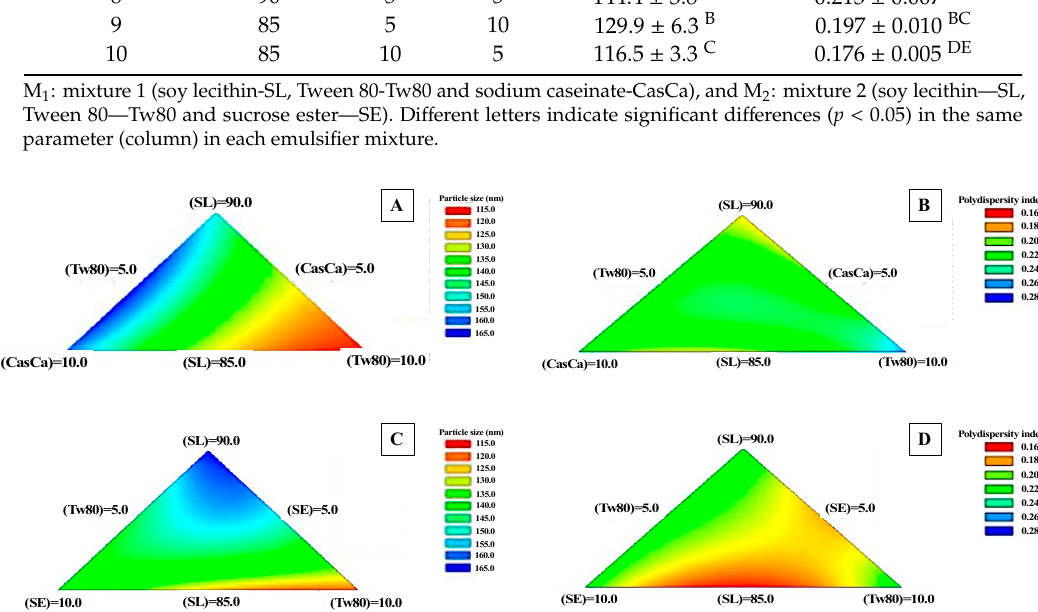
Figure 1. Mixture contour plots for particle size and polydispersity index of nanoemulsions elaborated with di ff erent emulsifier mixtures, ( A , B ): Mixture 1 (soy lecithin—SL, Tween 80—Tw80 and